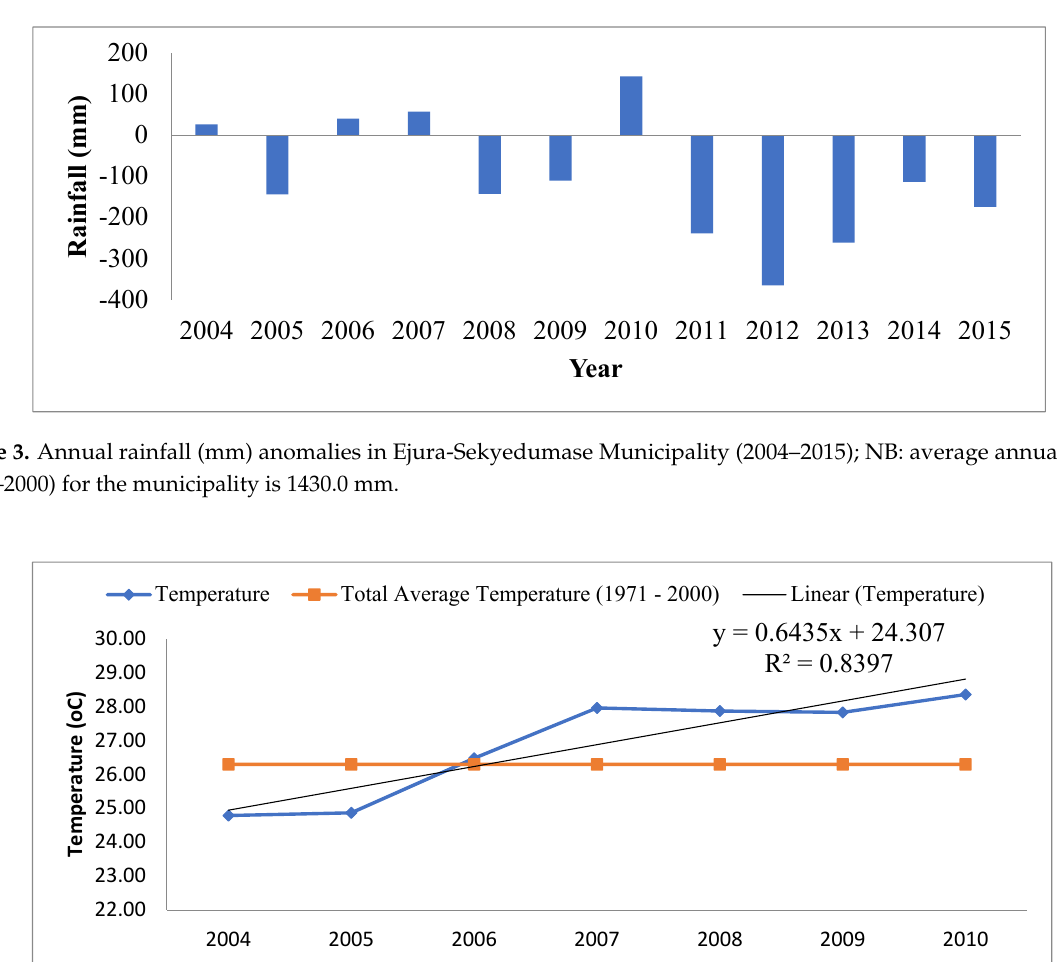
Figure 2. Annual rainfall (mm) in Ejura-Sekyedumase Municipality (2004–2015); NB: average annual rainfall (1971–2000) for the municipality is 1430.0 mm.